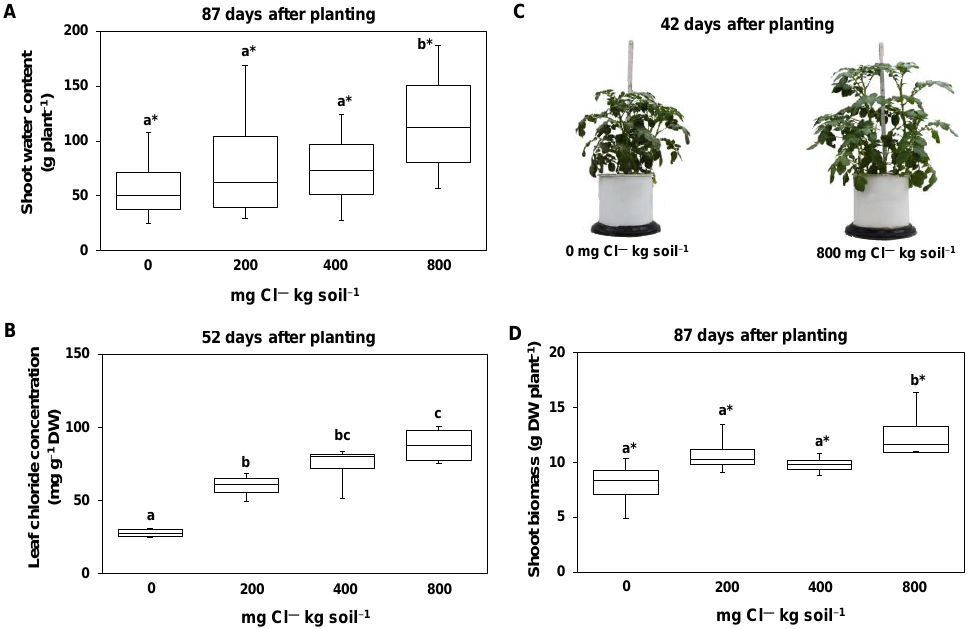
Figure 2. The effect of increasing chloride (Cl — )-fertilization on leaf chloride concentrations, shoot biomass, and shoot water content. Shoot water content at harvest (87 days after planting) ( A ), leaf Cl — concentrations 52 days after planting ( B ), representative phenotypes of plants being treated by 0 or 800 mg Cl — kg soil − 1 (folding rule: 62 cm) at 42 days after planting ( C ), and shoot biomass at harvest ( D ). Plants were treated with four Cl — supplies: 0 mg Cl — kg soil − 1 (control plants); 200 mg Cl — kg soil − 1 ; 400 mg Cl — kg soil − 1 ; 800 mg Cl — kg soil − 1 . Mean ± SE values; n = 4. Different lowercase letters indicate significant differences between Cl — treatments determined by multiple contrast test. Levels of significance: p < 0.05; * = p <